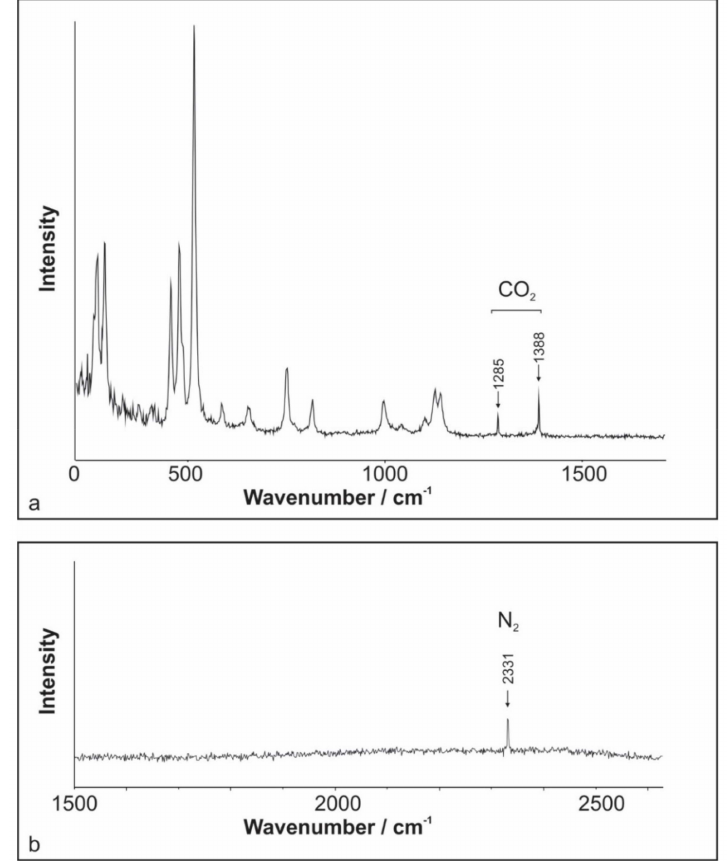
Figure 6. Raman spectra of the vapor bubble from an aqueous-carbonic inclusion reveal the presence of ( a ) CO 2 and ( b ) N 2